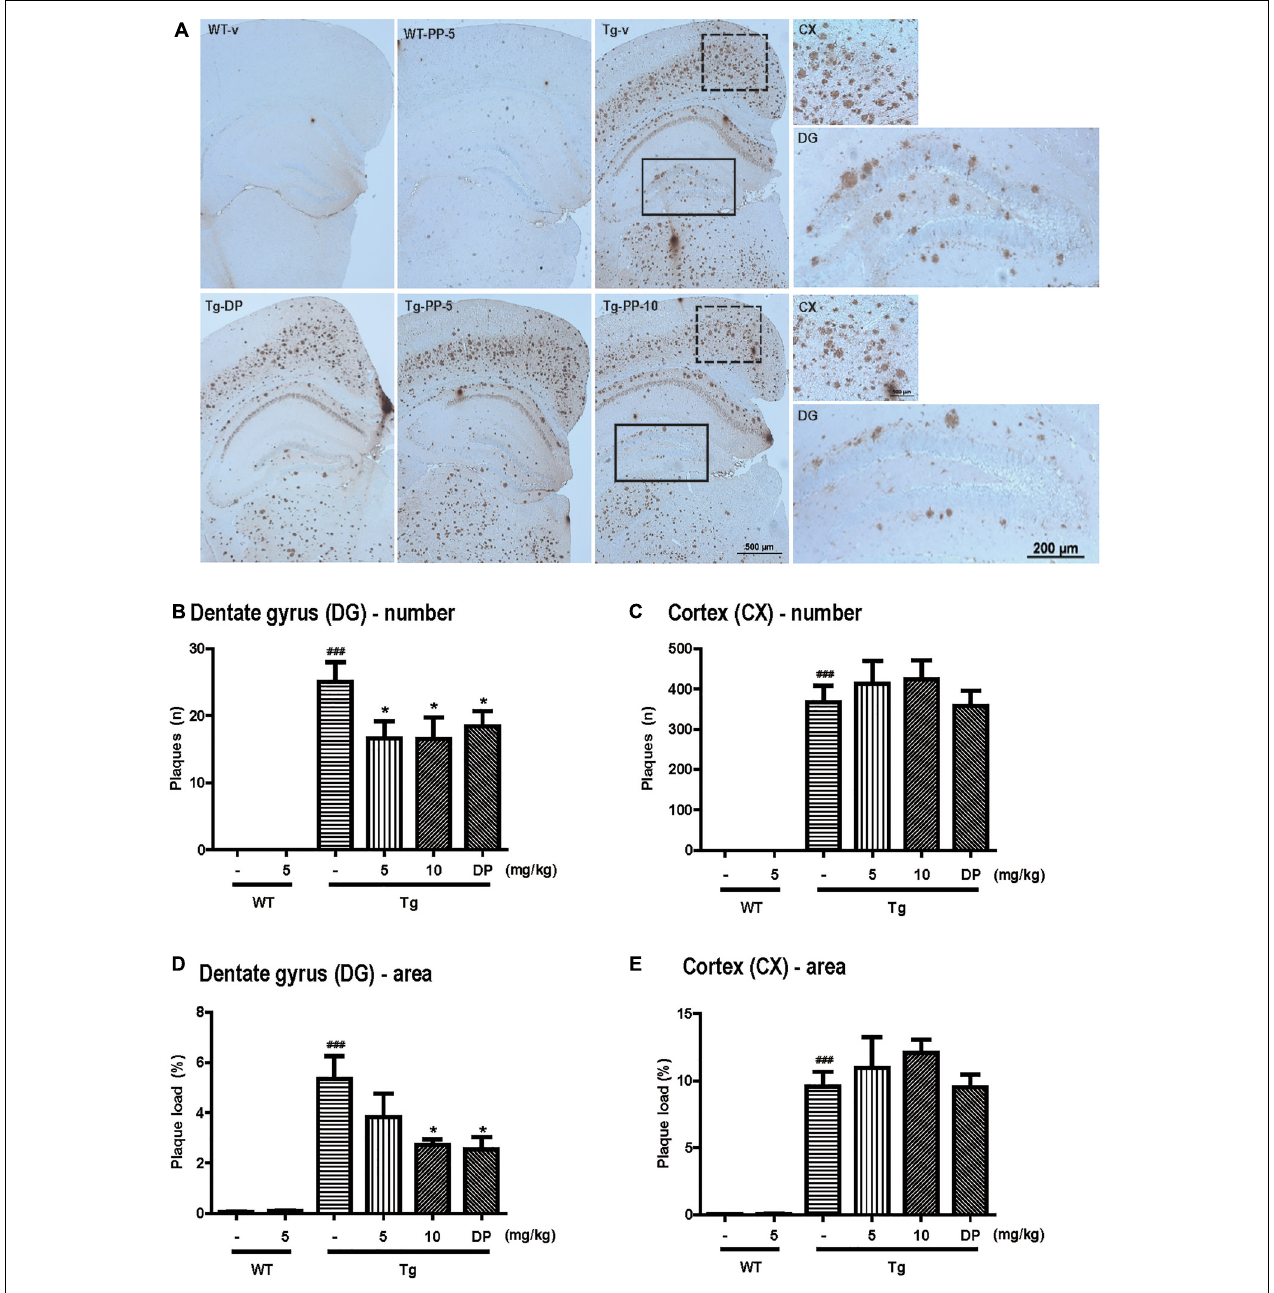
FIGURE 4 | PSM-04 reduced amyloid plaques in the brains of 5xFAD mice. (A) Immunohistochemistry using a 6E10 antibody to stain amyloid plaques in the brains. Amyloid plaques were calculated as plaque counts (B,C) and plaque area (D,E) in the dentate gyrus (B,D) and the cortex (C,E) . In the dentate gyrus, amyloid plaque counts (B) and plaque area (D) significantly reduced in PSM-04-treated Tg brains compared with the non-treated Tg brains. However, there was no change in the plaque count (C) and plaque area (E) in the cortexes of PSM-04-treated Tg brains and non-treated Tg brains. The statistical analyses were performed by one-way ANOVA, and data are presented as the means ± SEM. ### p < 0.001 vs. WT-v; ∗ p < 0.05 vs. Tg-v. WT-v ( n = 8); WT-PP-5 ( n = 9); Tg-v ( n = 7); Tg-PP-5 ( n = 6); Tg-PP-10 ( n = 6); and Tg-DP ( n =